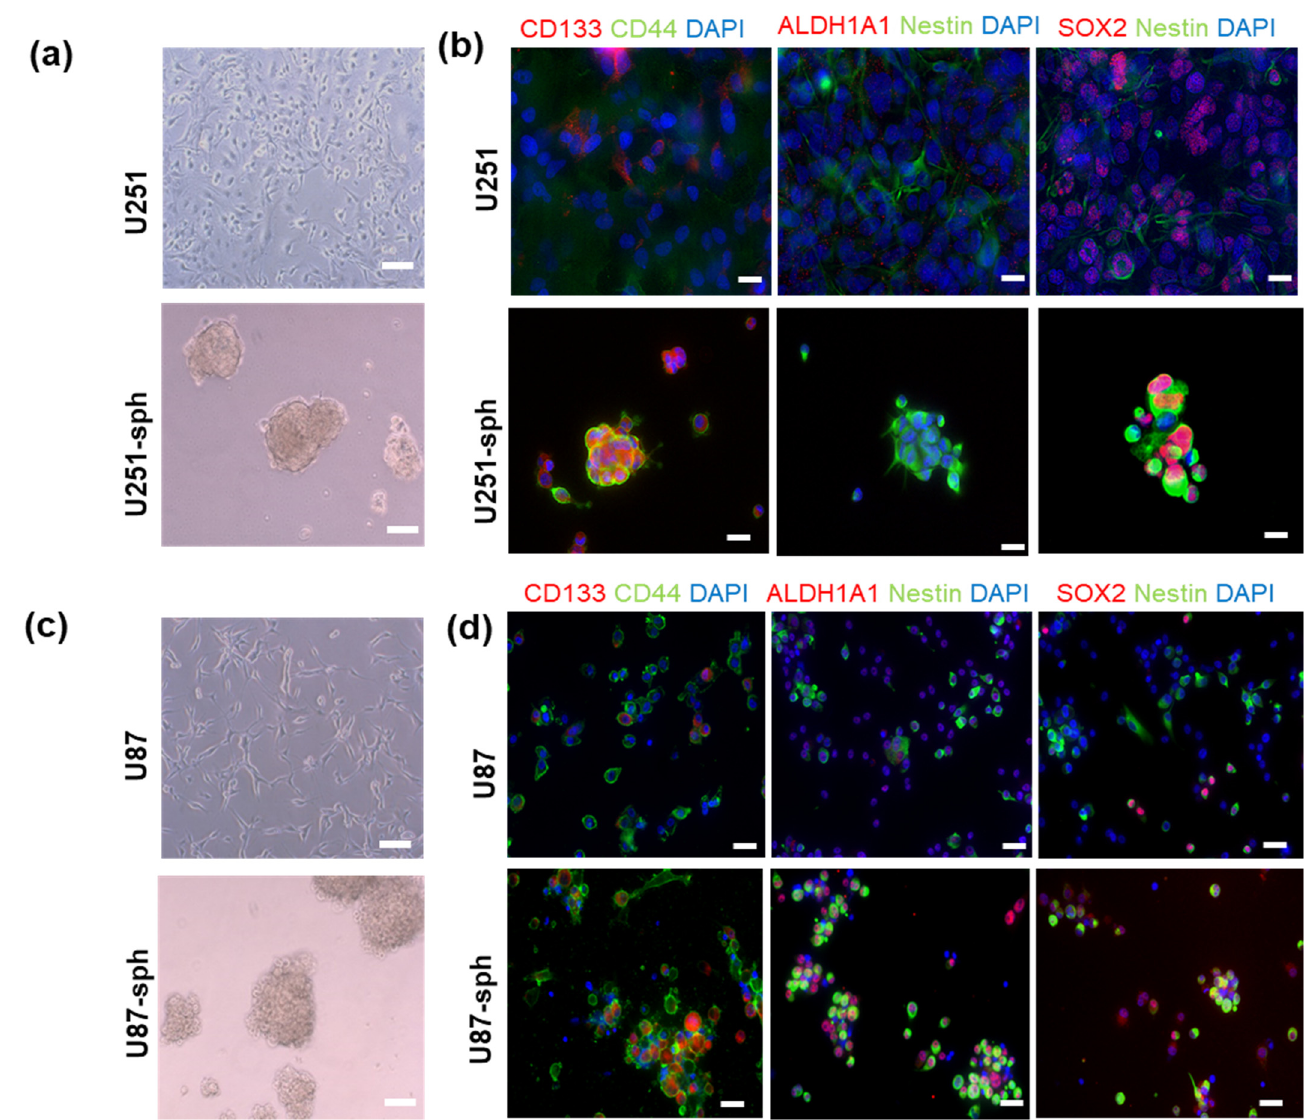
Figure 2. Induction of the stem-like phenotype in U251 and U87 cell lines by a spheroid culture. ( a ) Representative images of the morphology of U251 (cultured in the medium containing 10% FCS) and U251-sph (cultured in the serum-free medium; scale bar: 100 µm). ( b ) Representative images of co-immunofluorescence staining of U251 and U251-sph. The U251-sph cells showed an increased dual expression of the GSLC markers CD133 (red), CD44 (green), Nestin (green) and SOX2 (red) compared to the U251 cells. Nuclei were stained with DAPI (blue). Scale bar: 100 µm. ( c ) Representative images of the morphology of U87 (cultured in the medium containing 10% FCS) and U87-sph (cultured in the serum-free medium; scale bar: 100 µm). ( d ) Representative images of immunofluorescence staining of U87 and U87-sph. The U87-sph cells showed an increased co-expression of the GSLC markers CD133 (red), CD44 (green), ALDH1A1 (red), Nestin (green) and SOX2 (red) compared to the U87 cells. Nuclei were stained with DAPI (blue). Scale bar: 100 µm.